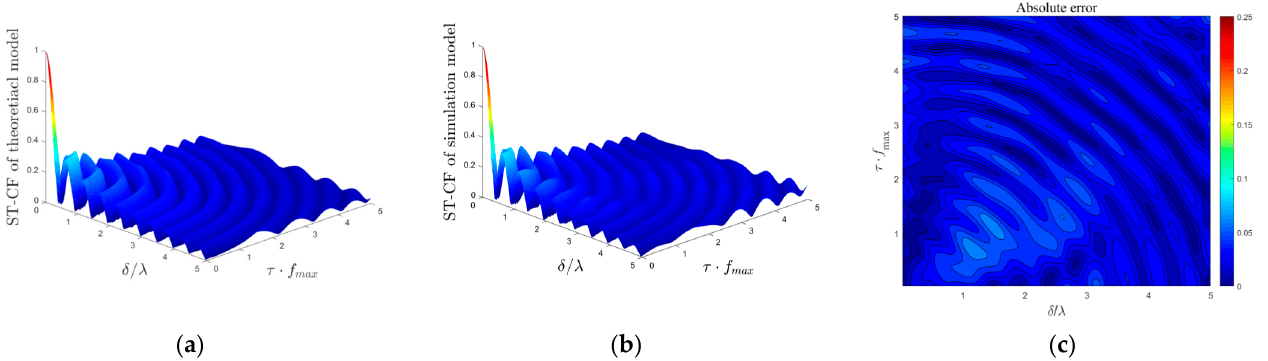
Figure 10. ( a ) ST-CFs of theoretical model in an isotropic scattering environment, ( b ) ST-CFs of simulation model in an isotropic scattering environment, and ( c ) the corresponding absolute error between ( a ) and ( b ).